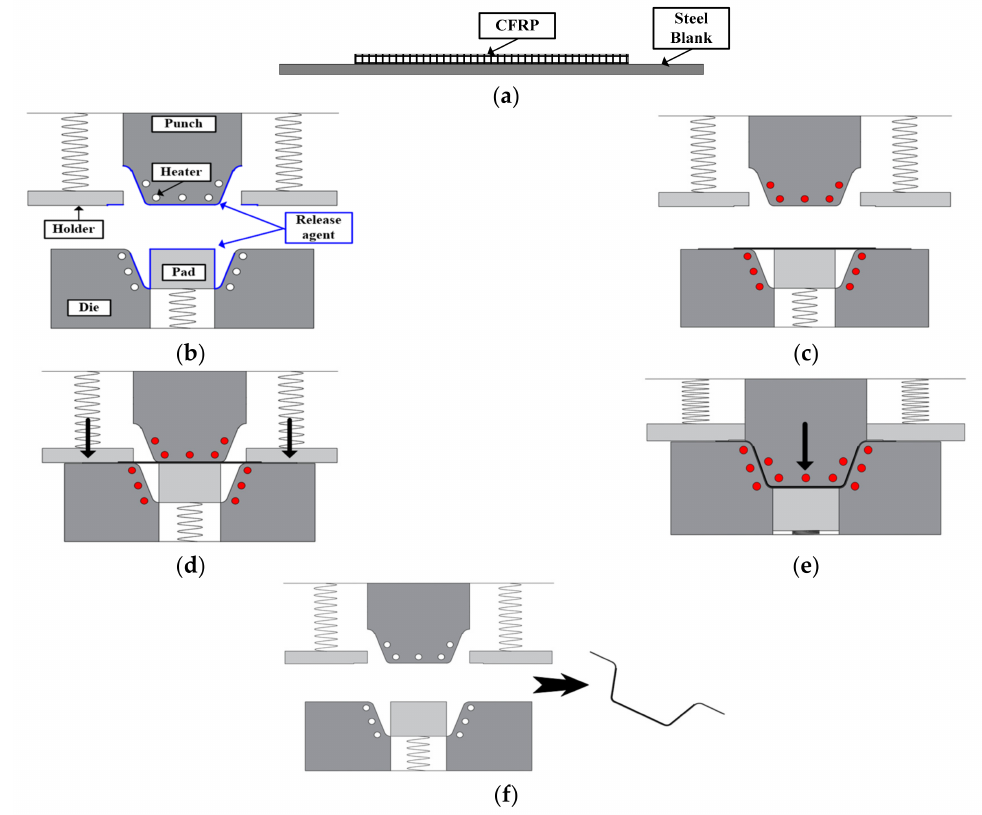
Figure 12. Manufacturing process of Steel/CFRP hybrid part: ( a ) stacking prepreg on steel blank; ( b ) spreading release agent; ( c ) tool heating; ( d ) blank holding; ( e ) forming and curing; ( f ) ejecting.